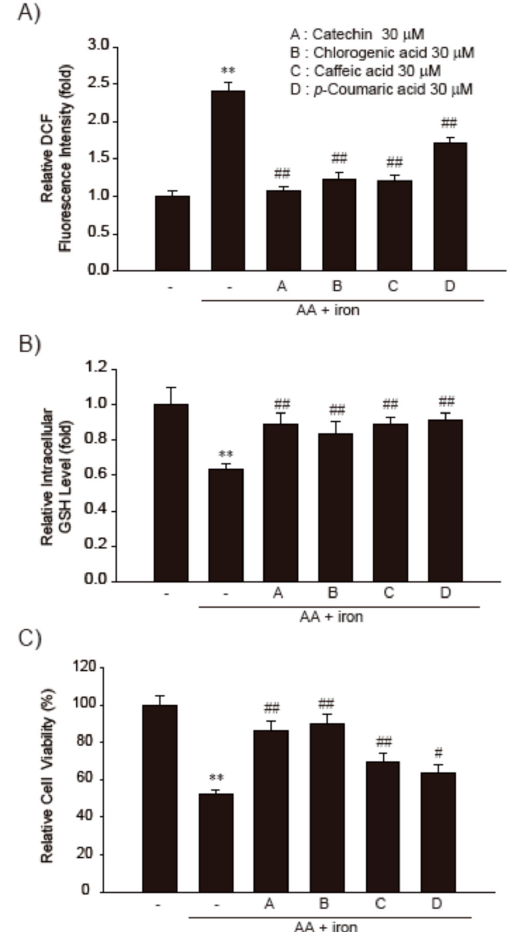
Figure 5. The cytoprotective effects of major polyphenols of the PN3. ( A ) HepG2 cells were incubated with AA (15 h) + iron (1 h) and/or 30 µM major polyphenols of PN3 (catechin, chlorogenic acid, caffeic acid, or p -coumaric acid). Cells were stained with 10 µM DCFH-DA for 30 min at 37 °C. Intracellular fluorescence intensities were measured using a fluorescence microplate reader. ( B ) The GSH concentrations were measured in the lysates of cells treated with AA (15 h) + iron (2 h) and/or 30 µ M of major polyphenols of PN3. ( C ) Cell viability. Cells were treated with AA (15 h) + iron (6 h) and/or 30 µ M major polyphenols of PN3 (catechin, chlorogenic acid, caffeic acid, or p -coumaric acid). Data represent the mean ± SD of three replicates; ** p < 0.01, significant versus vehicle-treated control; # p < 0.05, ## p < 0.01, significant versus AA + iron